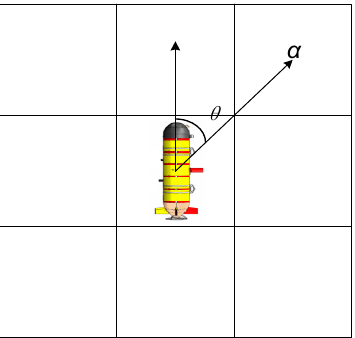
Figure 4. AUV steering schematic diagram.